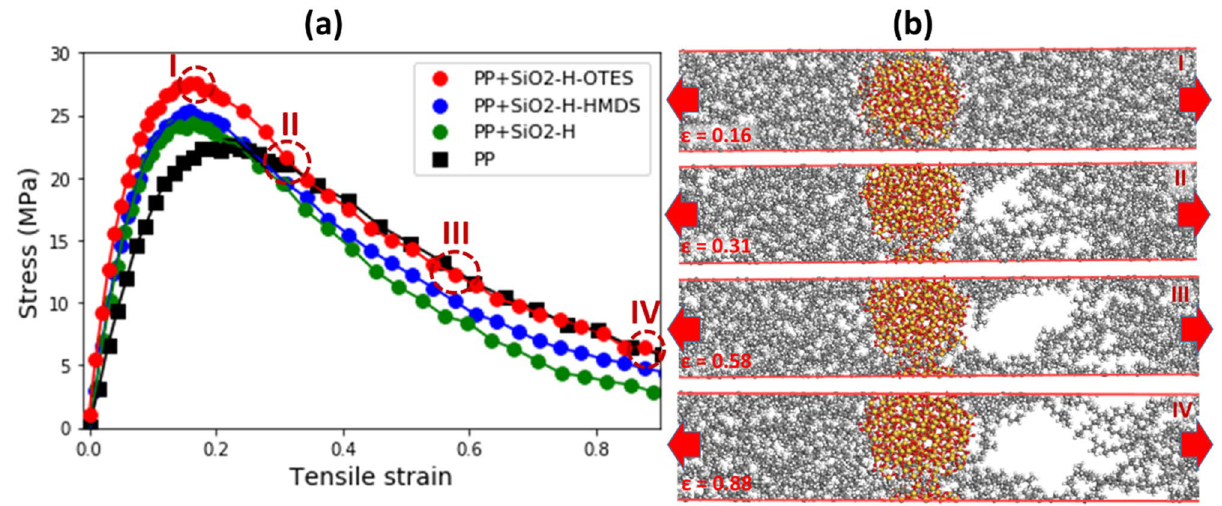
Figure 5. ( a ) Stress–strain curves calculated from the deformation of the PP composites subjected to an applied uniaxial tensile stress. The PP composites containing silica nanoparticles passivated only by hydrogen (green circles) and in addition functionalized with HMDS (blue circles) or OTES (red circles) molecules are shown. The stress–strain curve for the amorphous PP matrix (black squares) is added for comparison. The sequence of atomistic snapshots corresponding to the selected points (I, II, III and IV) on the stress–strain curve for the PP composite with SiO 2 passivated by hydrogen and functionalized with OTES is shown in ( b ). The mechanism of failure of PP composite via cavitation. The failure occurs via the void formation and growth in the vicinity of functionalized SiO 2 nanoparticle. The nucleated void grows rapidly, leading to the ultimate failure. Red arrows indicate the tension